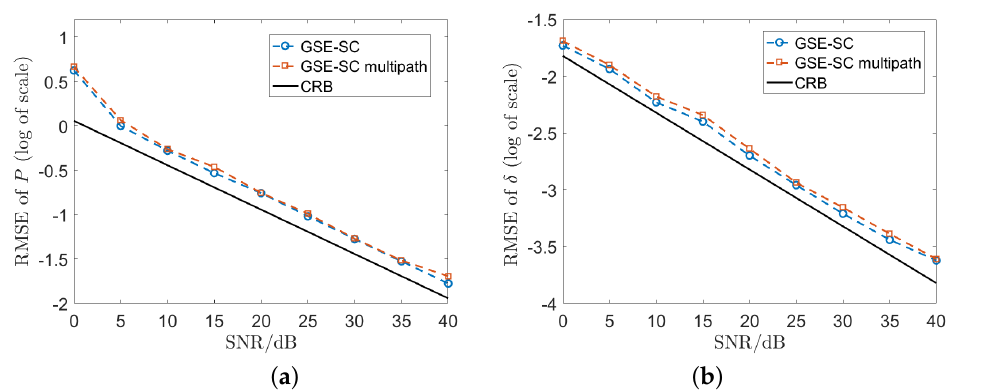
Figure 7. RMSEs of P and δ versus the multipath effect. ( a ) RMSE of P ; ( b ) RMSE of δ